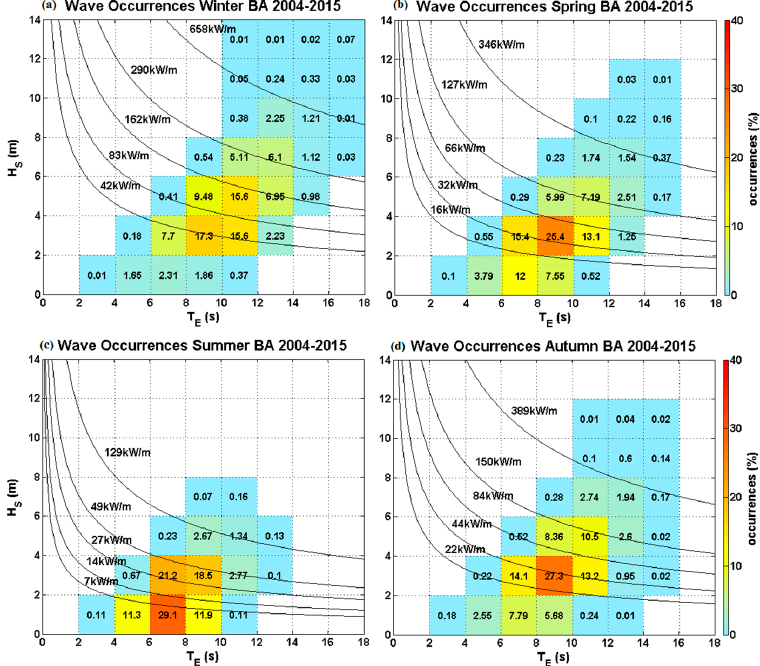
Figure 22. Bi-variate scatter plot for BA for ( a ) winter; ( b ) spring; ( c ) summer; and ( d ) autumn showing percentage of occurrences of H s and T E , with wave power isolines included.